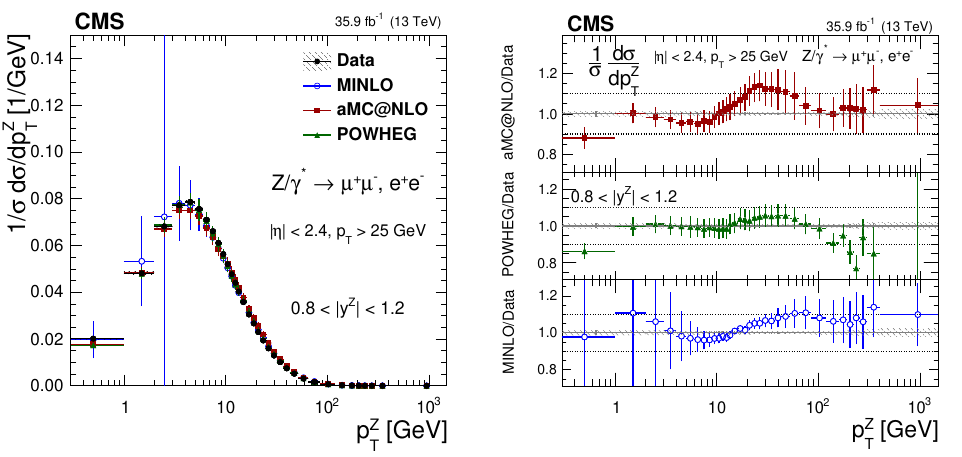
Figure 17 . The measured normalized cross sections (left) in bins of p Z region. The ratios of the predictions to the data are also shown (right). The shaded bands around the data points (black) correspond to the total experimental uncertainty. The measurement is compared to the predictions with MadGraph 5 a mc@nlo (square red markers), powheg (green triangles), and powheg - MINLO (blue circles). The error bands around the predictions correspond to the combined statistical, PDF, and scale uncertainties.